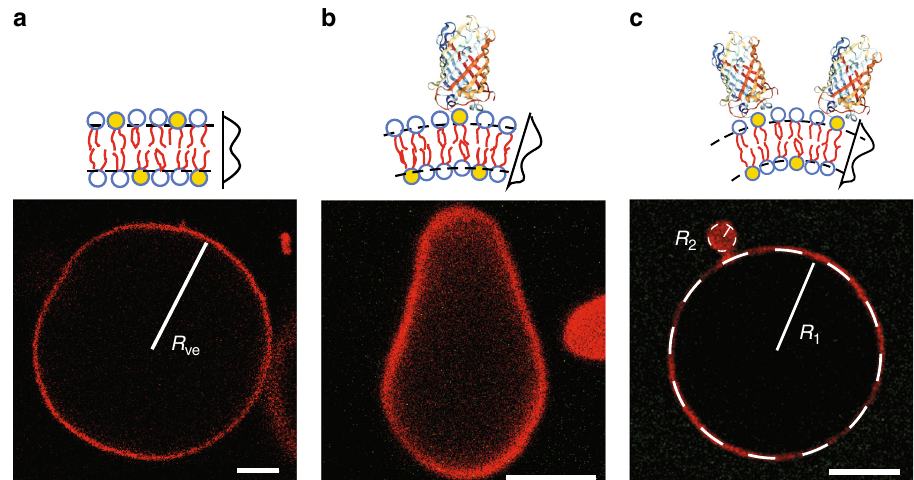
Fig. 1 Curvature of GUV membranes induced by His-tagged GFP. Cartoons of lipid bilayers and confocal images of GUVs a in the absence of GFP, that is, for GFP solution concentration X = 0 nM and GFP coverage Γ = 0 μ m − 1 . b For X = 0.78nM and Γ = 5.4 μ m − 2 . c For X = 7.8 nM and Γ = 54 μ m − 2 . In the cartoons, the anchor-lipids (yellow) bind the His-tags of the bulky GFP barrels (multi-colored). These protein barrels have an extension that is comparable to the lipid bilayer thickness of about 4nm. The average separation of the membrane-bound GFPs is much larger than the bilayer thickness and equal to 136 nm for the right-most cartoon with Γ = 54 μ m − 2 (not drawn to scale). In the confocal images, the GUV membranes (red) were doped with 0.1 mol% lipid dye. ffiffiffiffiffiffiffiffiffiffiffiffiffiffiffi p (cid:3) A = ð 4 π Þ ¼ 14 : 5 μ m. c The image shows a dumbbell a The image displays a spherical GUV with vesicle size R ve , related to the membrane area A via R ve shape consisting of two spherical membrane segments with radii R 1 = 7.27 μ m and R 2 = 0.92 μ m. These two segments are connected by a closed membrane ¼ 1 ð R (cid:2) 1 þ R (cid:2) 1 Þ ¼ 0 : 61 μ m − 1 (see the “ Methods ” section, Eq. (4)). All scale bars: 5 μ neck with neck curvature M 1 2 ne 2